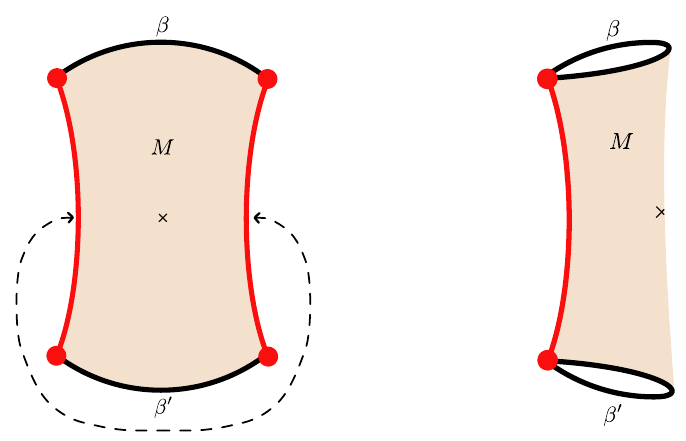
Figure 4 . The wormhole X is deconstructed on the left figure. It corresponds to a portion of an Euclidean black hole, cut by the trajectories of two thin shells, which are then identified. On the right, the resulting R × S 1 × S d − 1 topology connecting both boundaries. The mass M of the wormhole only depends on the combination β + β 0